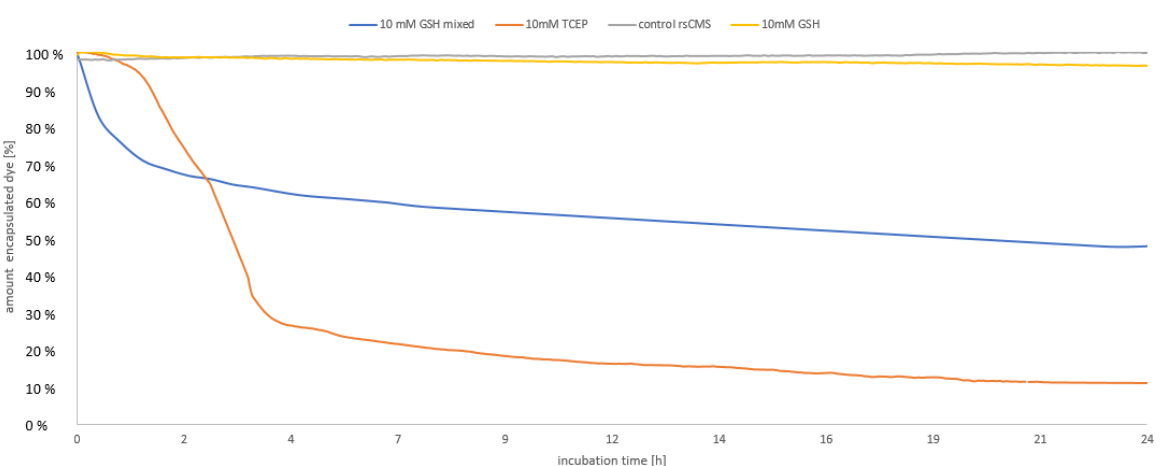
Figure 2. Kinetics of stimulus-triggered release of Nile red (NR) from rsCMS 1a measured with fluorescence spectroscopy over 24 h; NR release was followed by fluorescence intensity decay at NR emission maximum wavelength.